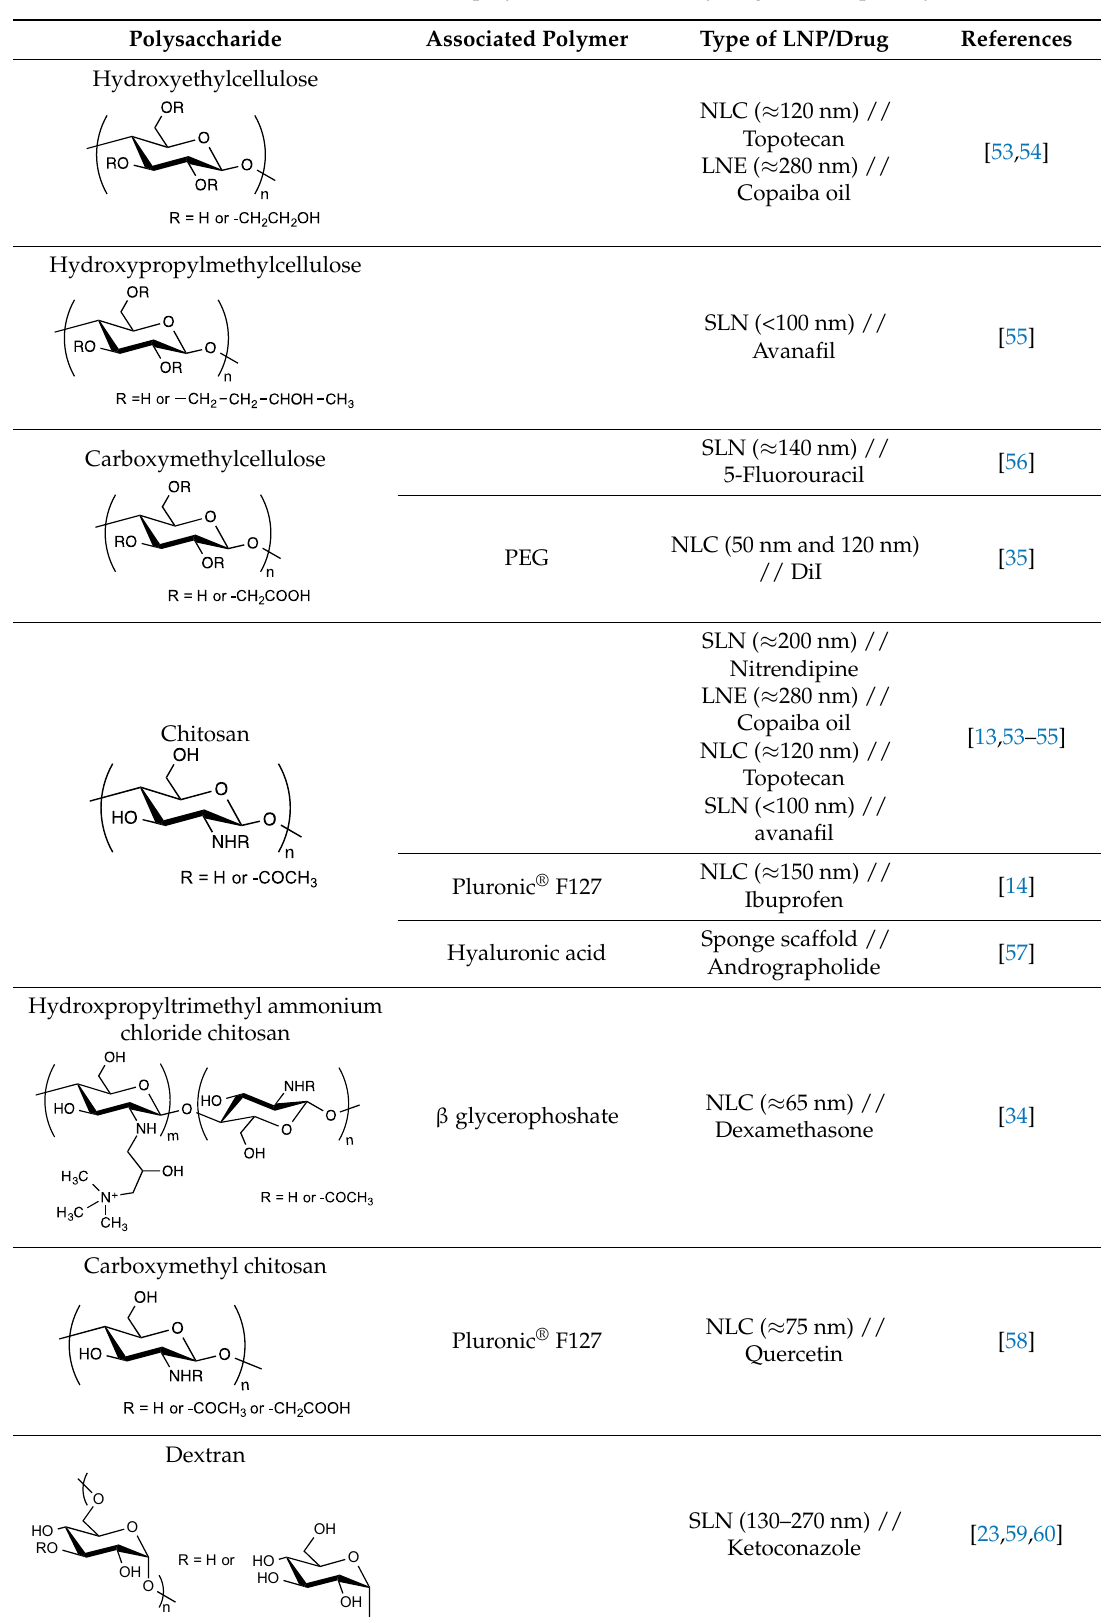
Table 2. Combination of LNP and polysaccharide-based hydrogels in the past 5 years.